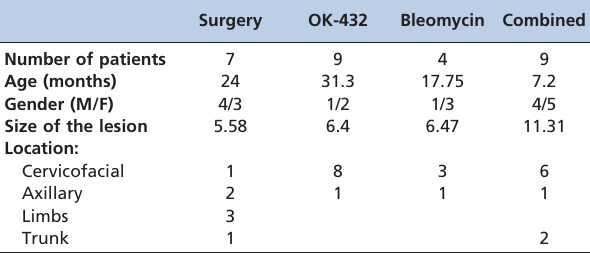
Table 1 - Characteristics of the patients.